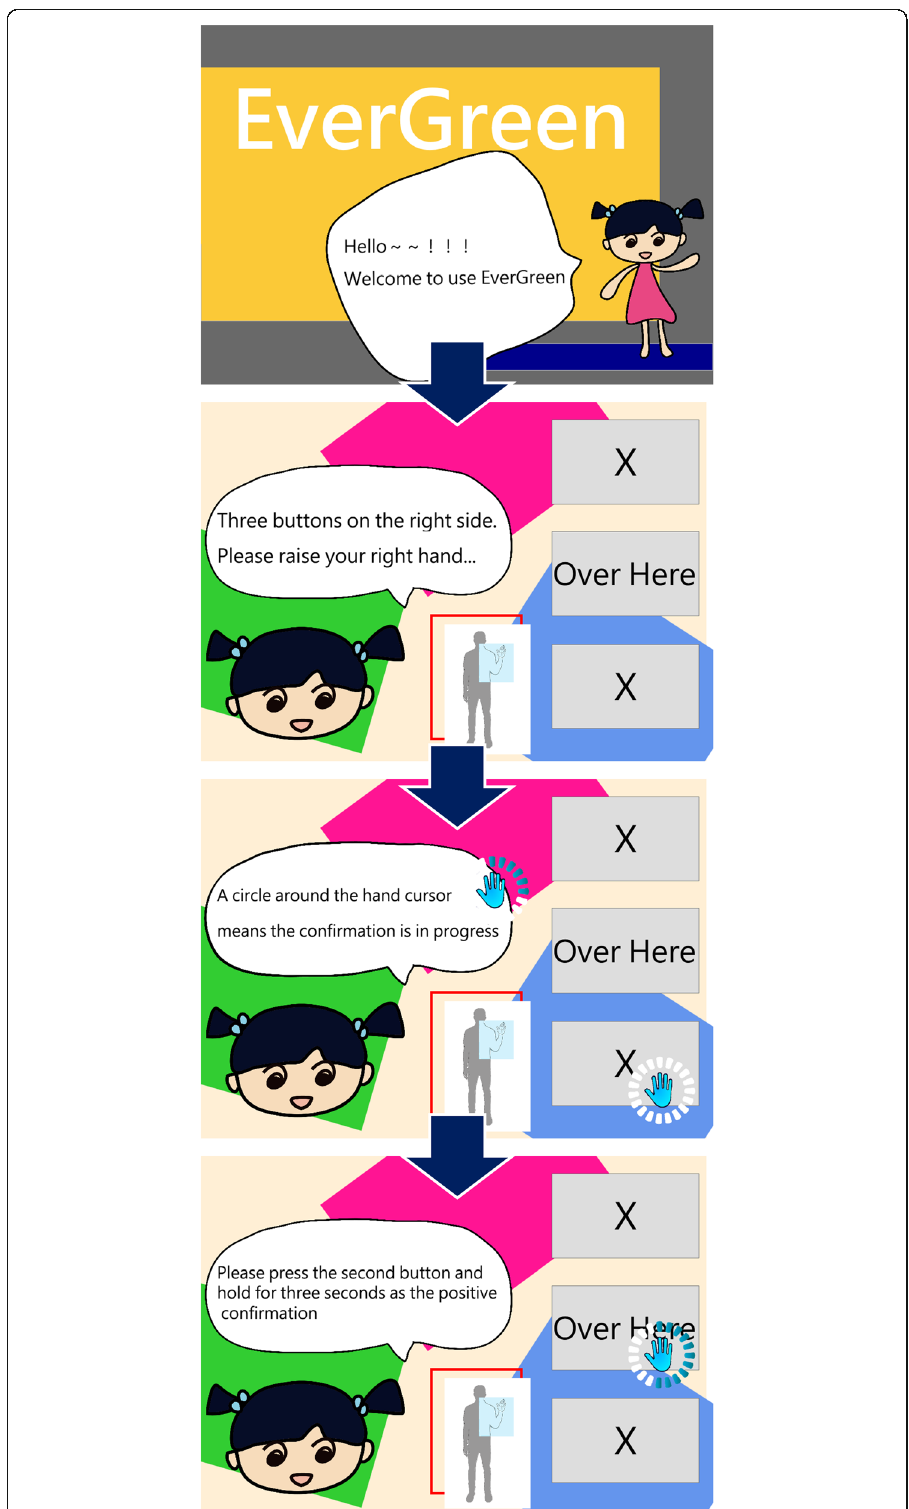
Fig. 5 The operational instruction of the hand cursor in the EverGreen